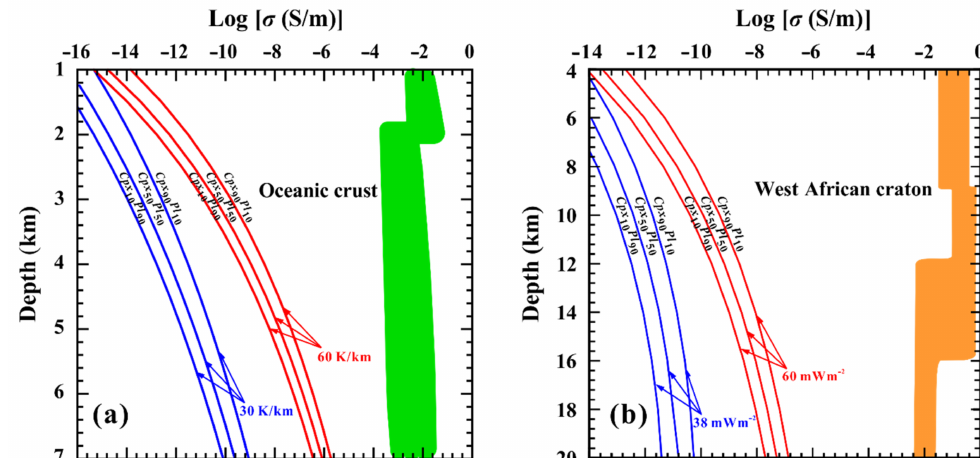
Figure 11. Laboratory-based conductivity–depth profiles constructed from the electrical conductivi- ties of the dry hot-pressed sintering gabbro ( Cpx 10 Pl 90 , Cpx 50 Pl 50, and Cpx 90 Pl 10 ) and the thermody- namic parameters, showing comparison with the conductivity for the anomalous high conductivity zones (HCZ) in the oceanic crust and West African craton, respectively. In ( a ), the red and blue solid lines represent the conductivity–depth profiles on the geothermal gradients of 60 K/km and 30 K/km, respectively. In ( b ), the red solid lines and the blue solid lines are based on the surface heat flow values of 60 mW/m 2 and 38 mW/m 2 , respectively. The green region represents the oceanic crust with a high conductivity anomaly in ( a ), and the MT data derived from a high-conductivity anomaly in the West African craton are shown as the orange region in ( b ) (reproduced with permission from the reference of Le Pape et al. [4], published by Elsevier, 2017; reproduced with permission from the reference of Drury [45], published by Oxford University Press,